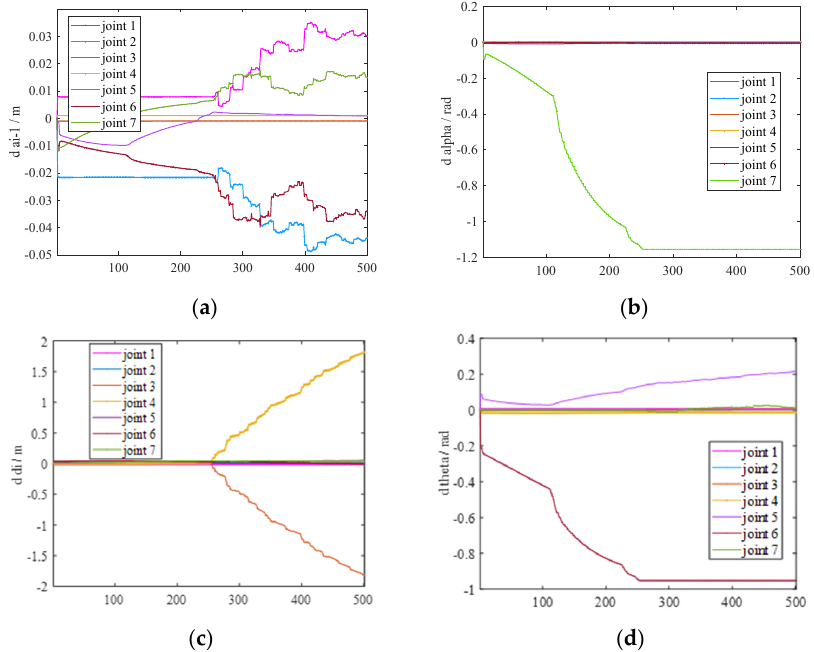
Figure 11. Identification of various parameters before elimination of redundancy error: ( a ) δ a i − 1 ; ( b ) δα i − 1 ; ( c ) δ d i ; ( d ) δθ i As observed, when redundancy error is not eliminated, the identification process is unstable, there is no convergence in the error term identification, and over-fitting exists, which indicates the correctness of error term elimination.